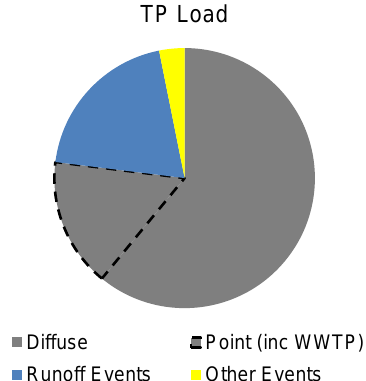
Figure 3. Pie chart showing proportion of 2005–2006. Observed TP load from different event and diffuse sources calculated from the HFD data